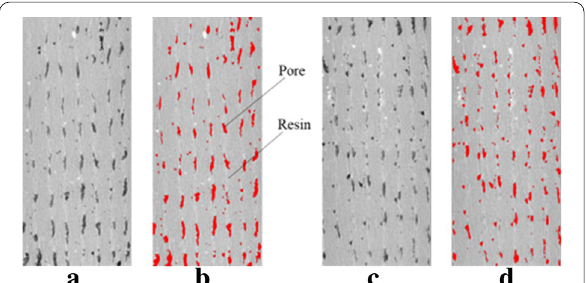
Figure 10 CT scanning images of the cross section at nozzle temperatures of a and b 180 °C, c and d 220 °C, b and d extracted pore